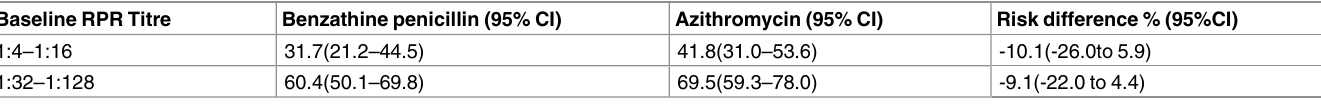
Table 4. Analysis of Serological Cure by Baseline RPR